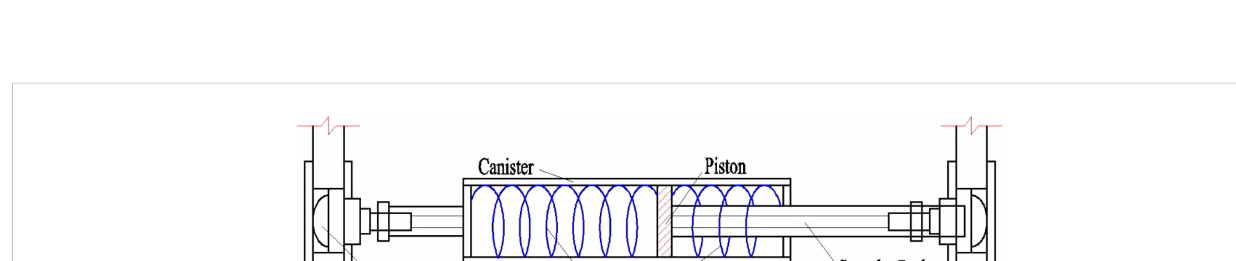
FIGURE 2 Designed fl exible connector of